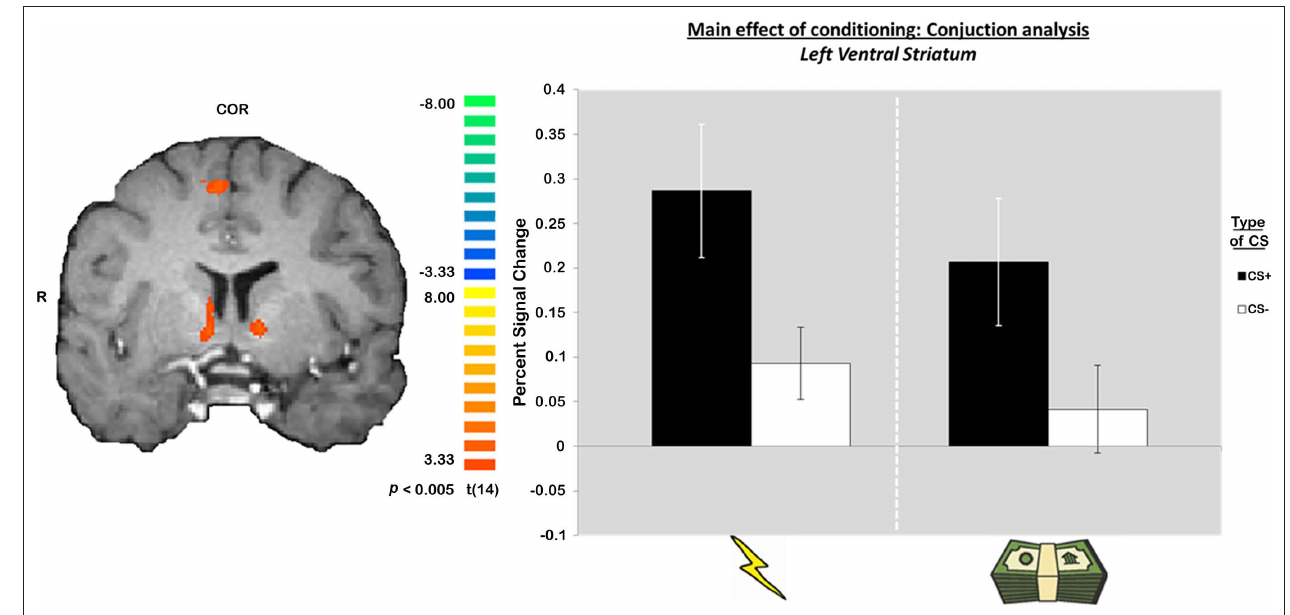
Figure 3 | Bilateral activation of the striatum identified during both conditioning sessions using a conjunction analysis. The graphs are included for visualization only. Error bars reflect SE from the